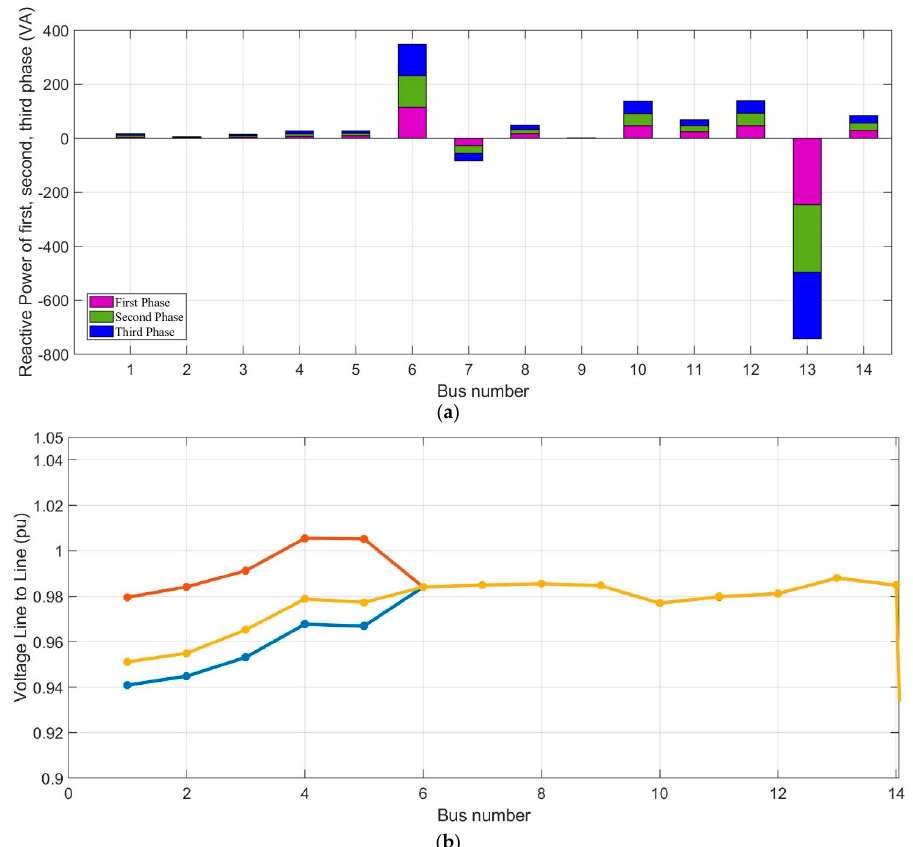
Figure 17. ( a ) The reactive power balance at minimum demand and ( b ) the voltage at minimum demand.